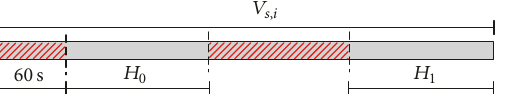
Figure 4: Extraction of video segments 𝐻 0 and 𝐻 1 containing boring and stressful game interactions, respectively. Initial 60 seconds of any video 𝑉 𝑠,𝑖 are ignored and the remaining is divided into three pieces, from which the first and the last ones are selected. Stripes highlight discarded video